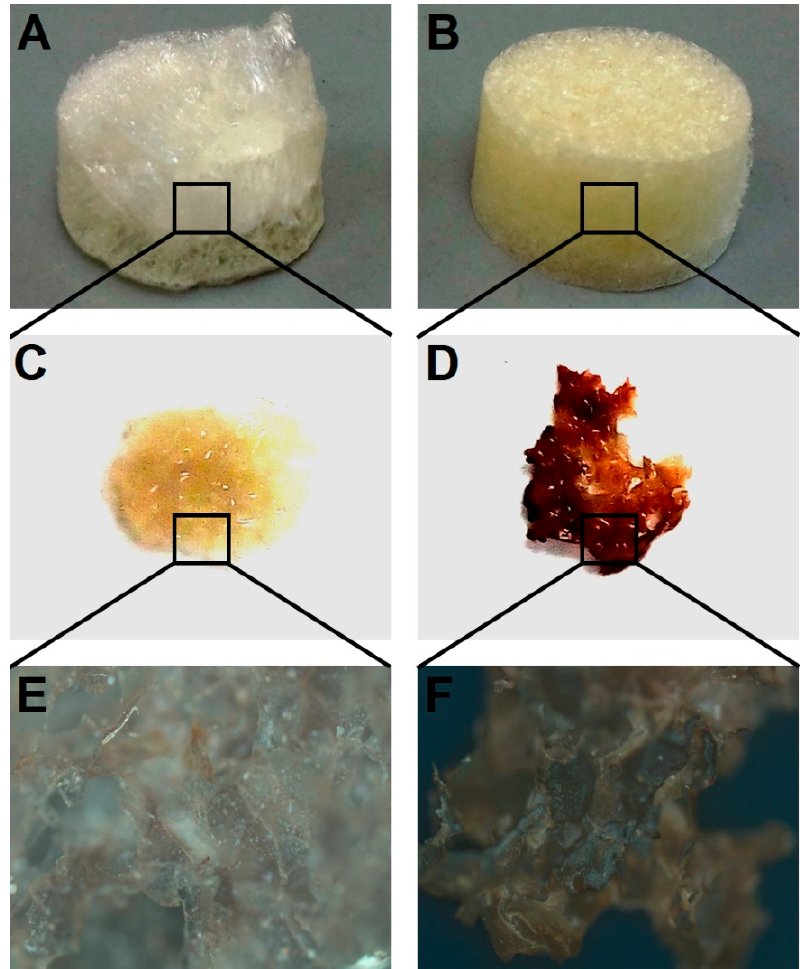
Figure 4. Qualitative analysis of osteogenic differentiation of MSCs on chitosan–agarose–gelatin scaffolds in presence of forskolin-loaded HNTs. Macroscopic view of scaffold with pristine HNTs ( A ) and scaffold doped with forskolin-loaded HNTs ( B ) before MSCs seeding; von Kossa staining of fragment of control scaffold with pristine HNTs ( C ) and scaffold doped with forskolin-loaded HNTs ( D ) with seeded MSCs after 14 d of incubation; visualization of control scaffolds with pristine HNTs ( E ) and scaffold doped with forskolin-loaded HNTs ( F ) with seeded MSCs after 14 d of incubation.